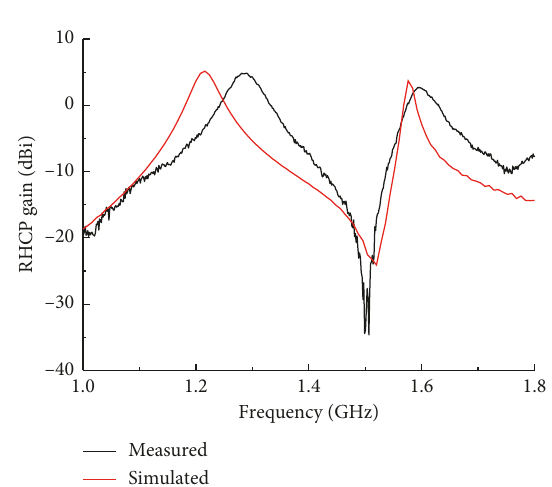
Figure 9: RHCP gain of the proposed